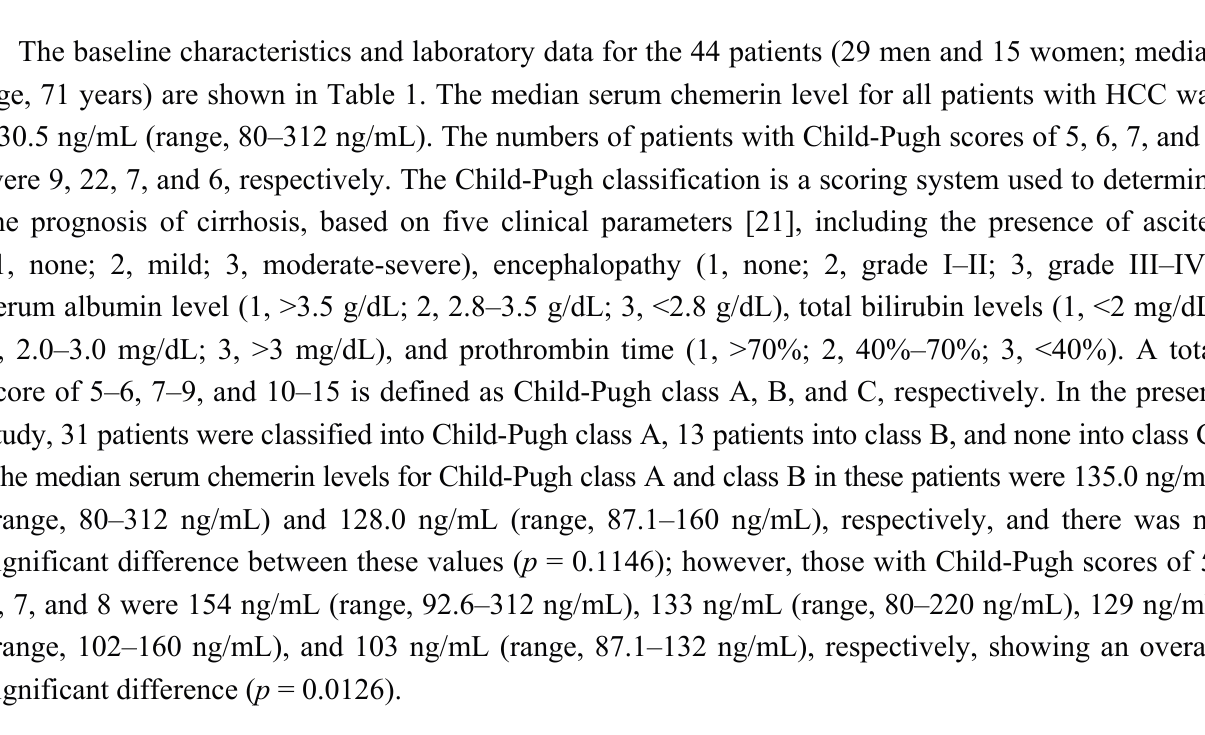
Table 1. Baseline demographic and clinical